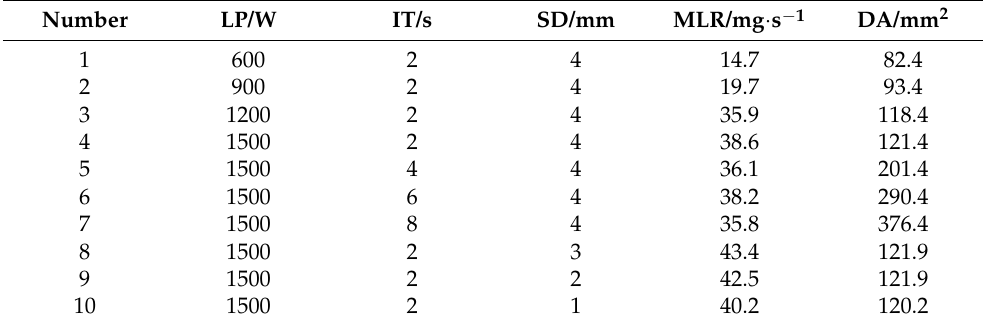
Table 1. Experimental parameters of the laser ablation test and experimental